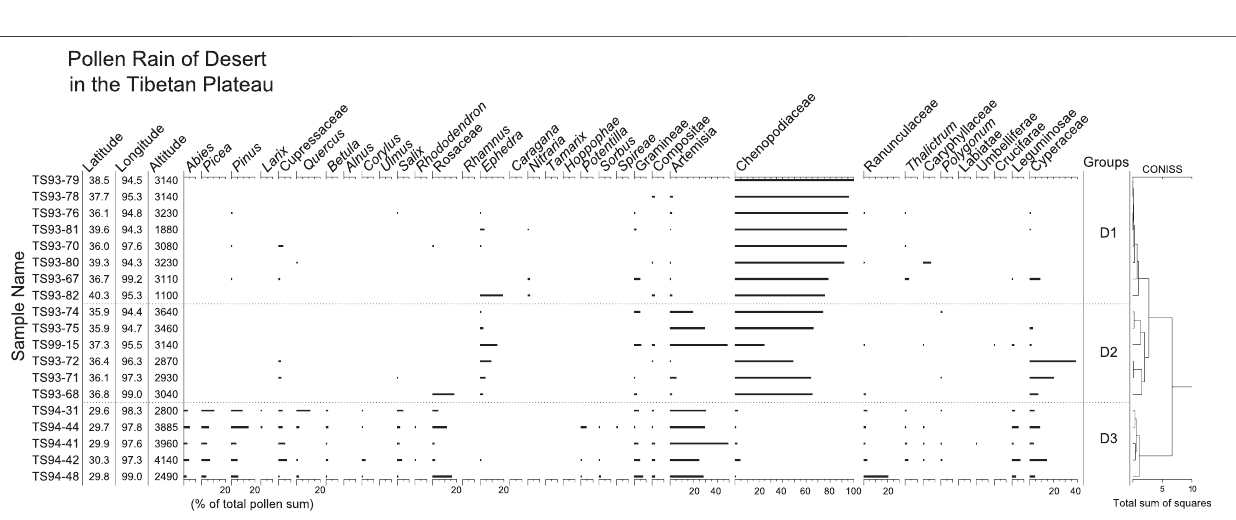
FIGURE 8 | Pollen percentage diagram for surface samples from deserts in the TP. Samples of groups D1 and D2 are from arid desert, and samples of group D3 from hot valley desert.